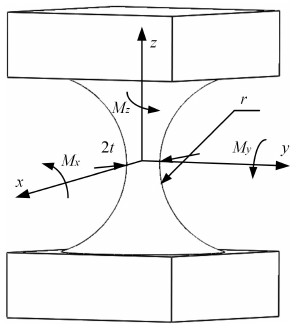
Figure 5. Right circle spherical joint.